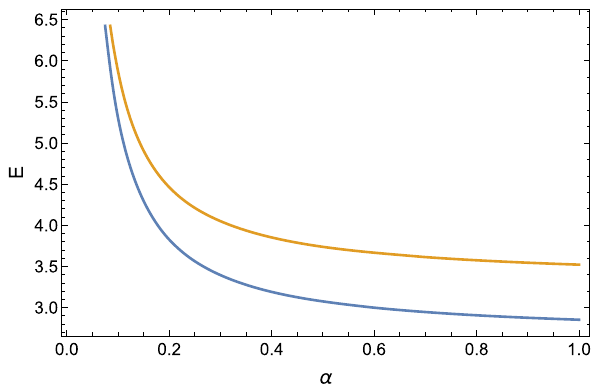
Fig. 1 Energy spectrum with s = 1 as a function of ω . The results are independent of α and m , with M = 1 and different values of n